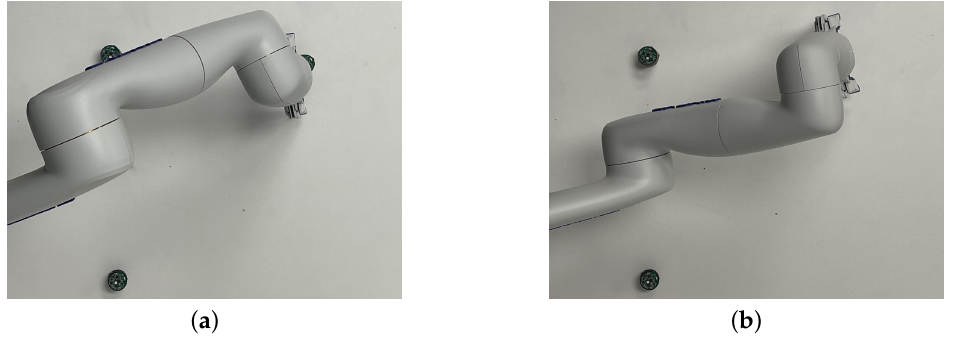
Figure 10. Two configurations of the arm for the same object-picking task. On the left, i.e., ( a ) solution no. 6, the other object is almost completely hidden, while the right solution, i.e., ( b ) solution no. 8, has a lot more